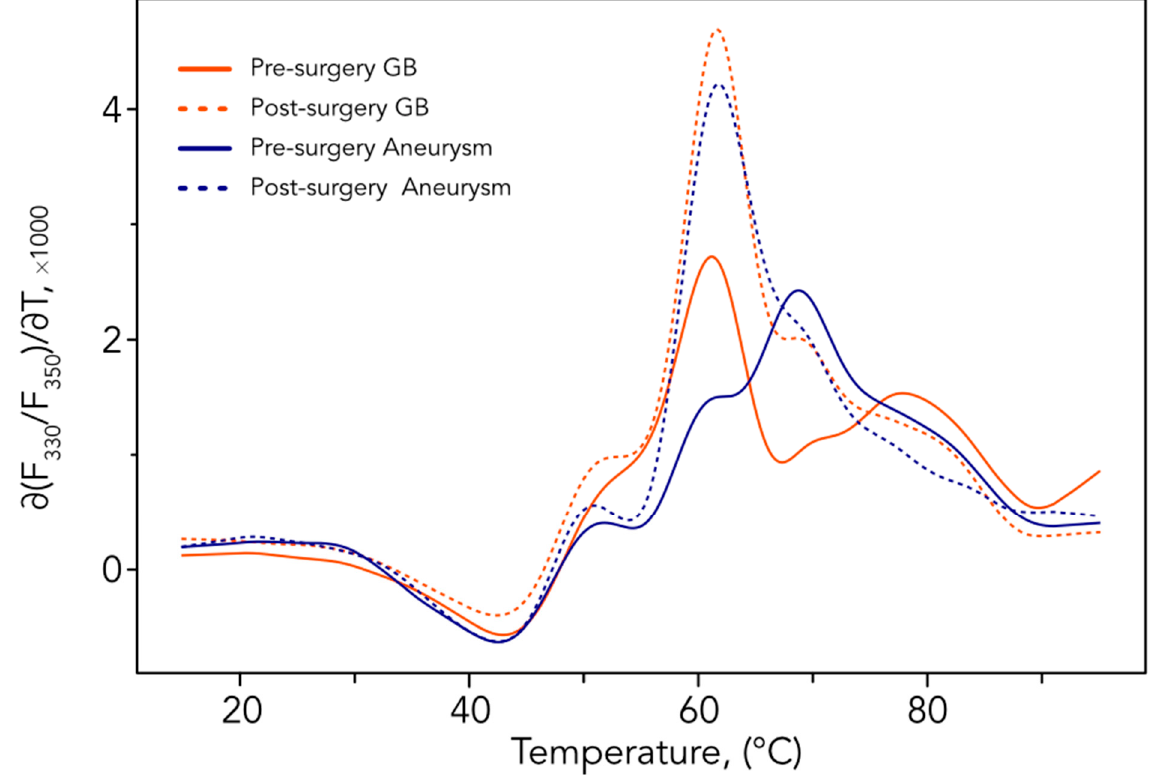
Figure 2. Means of the first derivatives of the ratio F 330 /F 350 . Comparison of aneurysm and GBM patients’ PDPs before and in the 48 h following surgery. All outputs of nanoDSF used for the analysis are shown in Figure S1.